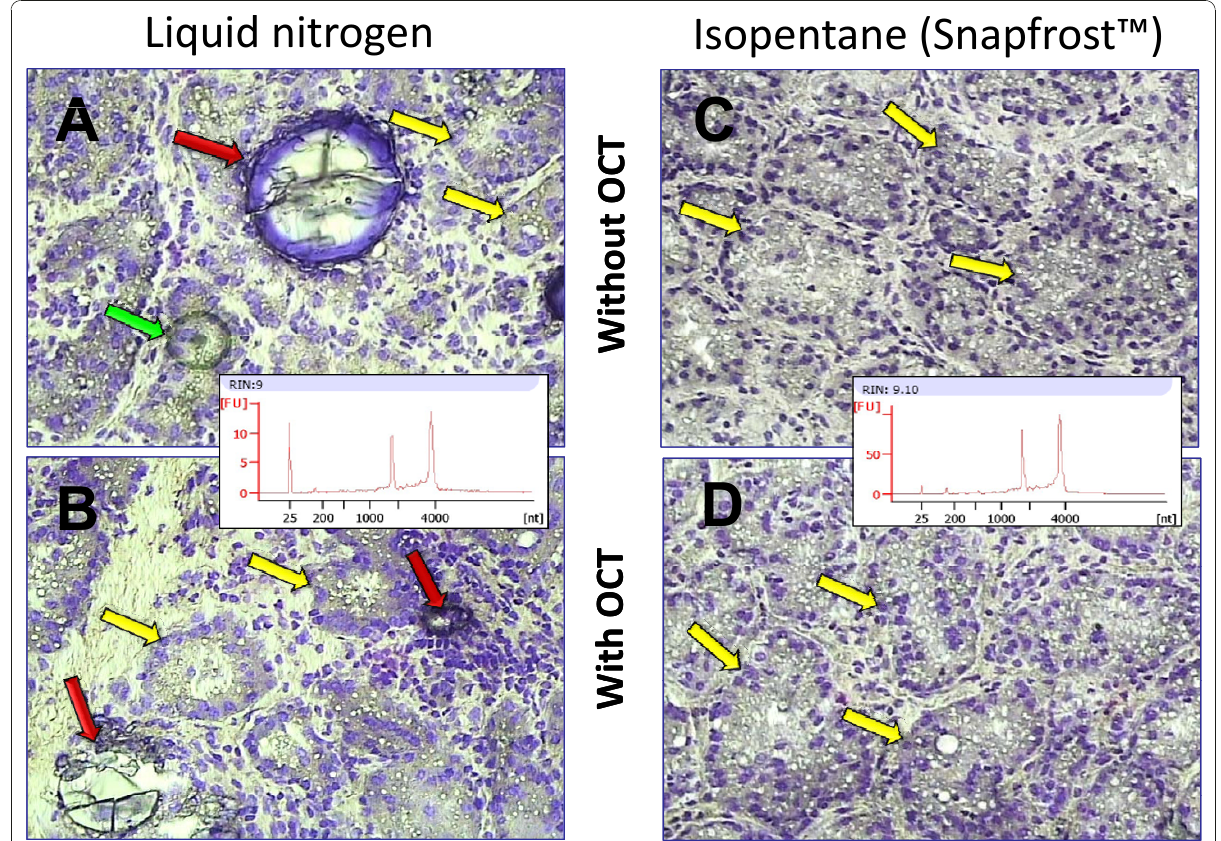
Figure 1 Impact of the freezing system on morphology of fresh mammary tissue sections and on quality of RNA extracted . Alveolar (acini) structures lined by MECs (yellow arrows) can be easily distinguished after staining mammary tissue sections with Cresyl violet AMBION. Immediately after collection, mammary tissue samples were washed in cold PBS solution, cut in cube of 3-4 mm thickness, and frozen in four different conditions: pieces of mammary tissue were either directly introduced into 1.5-ml eppendorf tubes and frozen in liquid nitrogen (A), or in cold isopentane (-80°C) using the SnapFrost ™ system (C), or embedded in OCT® contained in cryomold before to be immediately immerged in liquid nitrogen (B) or in cold isopentane (D). RNA quality (RIN) which was estimated by RNA 6000 Pico LabChip kit and Agilent 2100 Bioanalyzer, was identical (ranging between 8.5 and 9.5) whatever the freezing procedure, as illustrated in the electrophoreris profiles. Some large blisters (red arrows on Figure A and B) appear however in biopsy flash frozen in liquid nitrogen, mainly without cryoprotector, and morphological details are better seen on tissues frozen using the SnapFrost ™ system (Magnification: ×60). The green arrow indicates the thermoplastic film stuck on epithelial cells to be